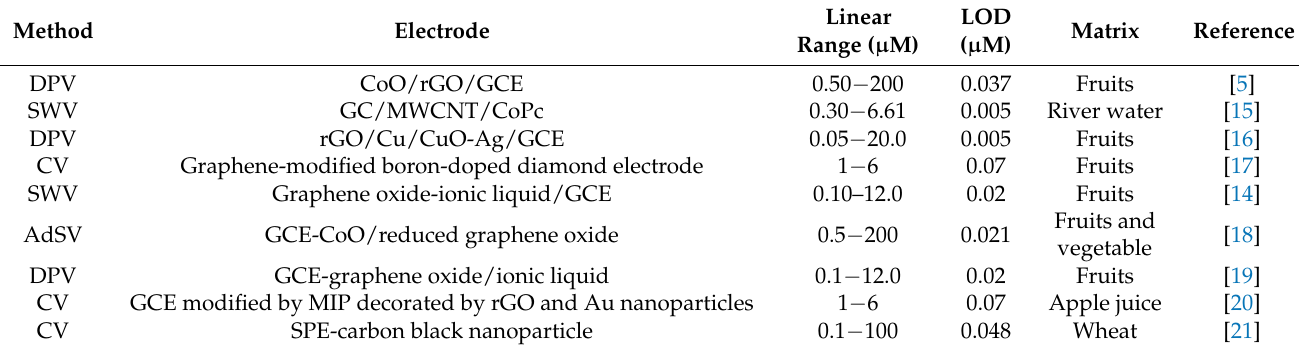
Table 1. Electrochemical methods for the determination of carbaryl in various matrices.